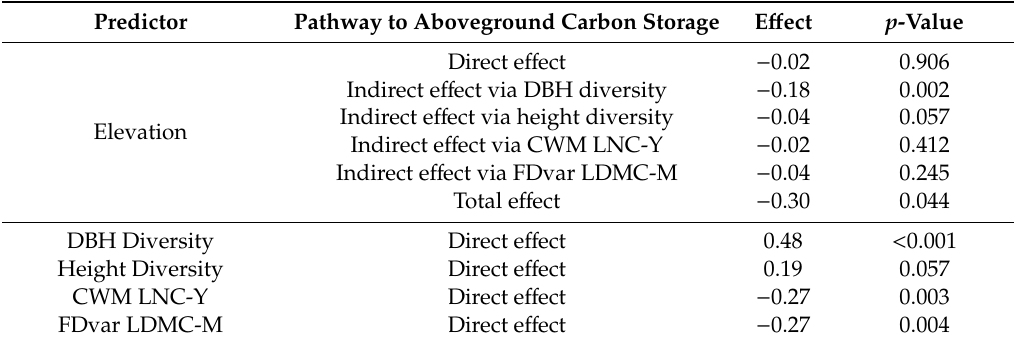
Table 4. Direct, indirect, and total standardized e ff ects on aboveground carbon storage based on the structural equation model. The indirect e ff ect of elevation was calculated by multiplying the standardized e ff ects of all paths on one route, from elevation to mediator, and then to aboveground carbon storage, while the total e ff ect was calculated by adding standardized direct and indirect e ff ects. Predictor Pathway to Aboveground Carbon Storage E ff ect p -Value Direct e ff ect − 0.02 0.906 − 0.18 0.002 − Elevation